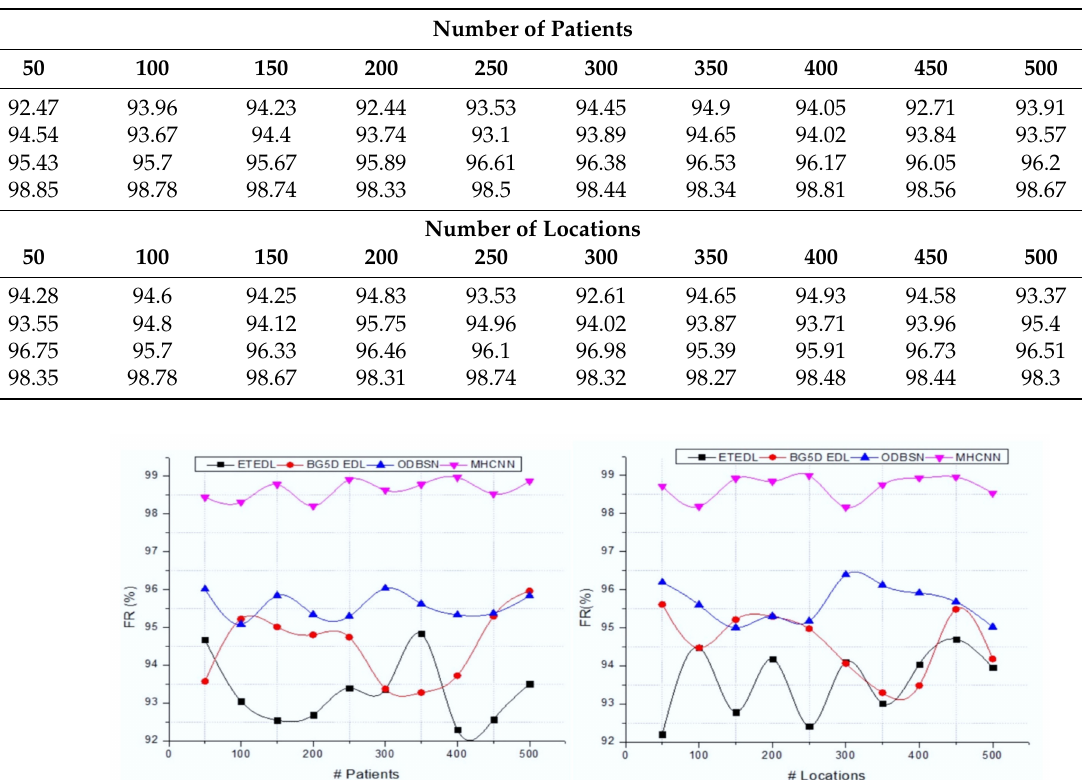
Table 3. Effectiveness of the system.